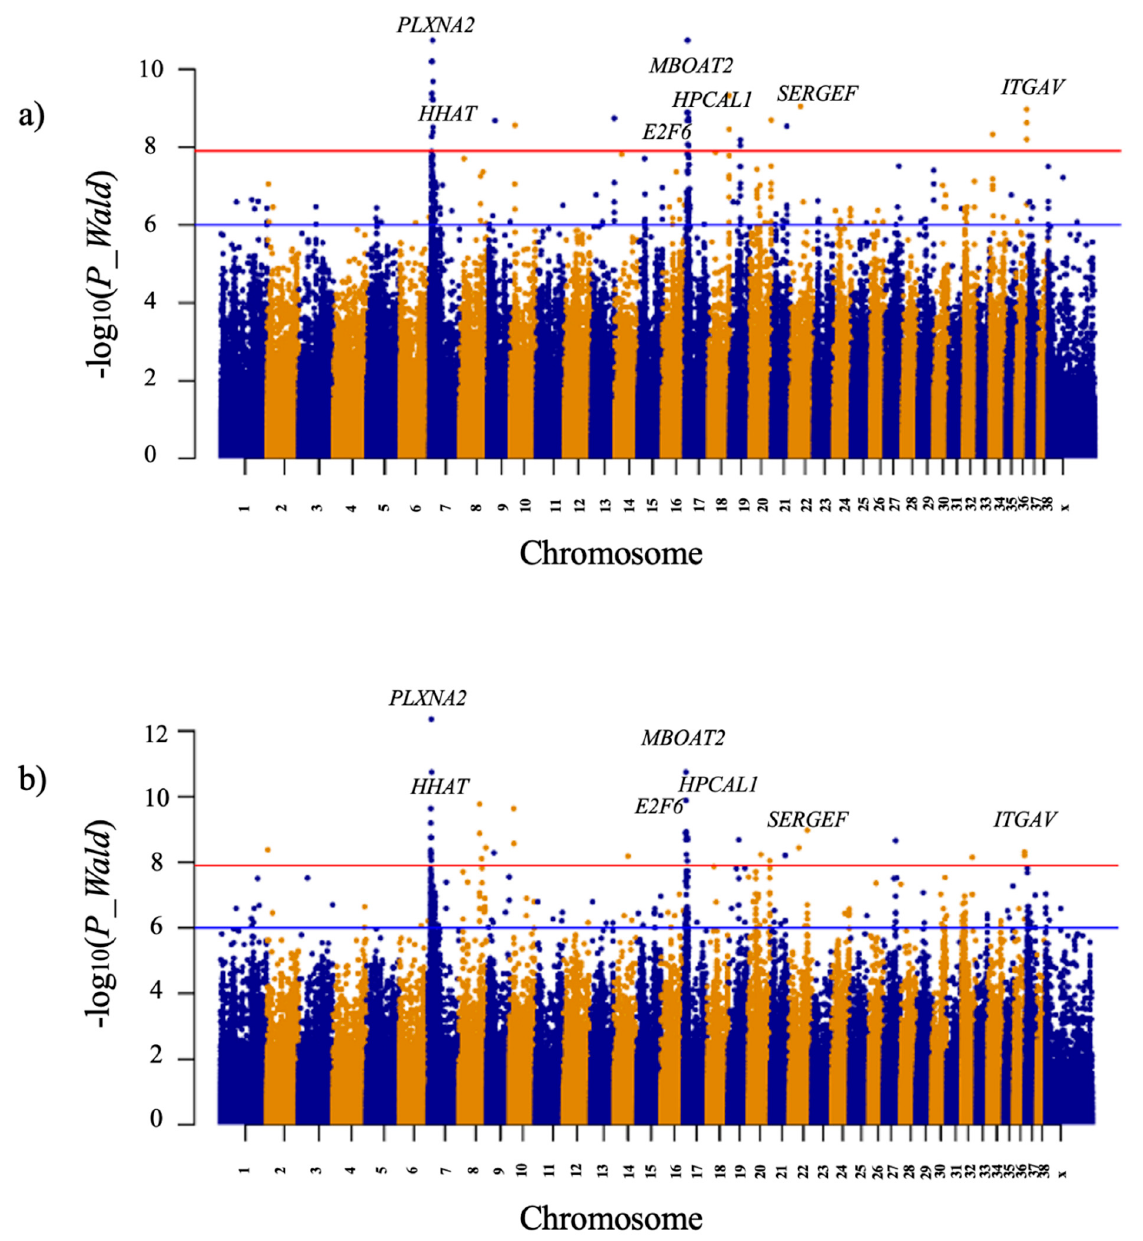
Figure 2. Manhattan plots of the genome-wide association studies (GWAS) for syringohydromyelia (SHM) development comparing ( a ) 12 French Bulldog (FB) SHM cases vs. 26 controls (10 FB, 16 samples from control panel 1), and ( b ) 12 French Bulldog SHM cases vs. 26 controls (10 FB, 16 samples from control panel 2) (Tables 1 and S1). The − log 10 p values for each SNP are plotted on the y-axis versus each canine autosome and the X-chromosome on the x-axis. The red line represents the Bonferroni corrected significant threshold ( − log 10 (P WALD ) = 7.9) and the blue line the suggestive threshold ( − log 10 (P WALD ) = 6).